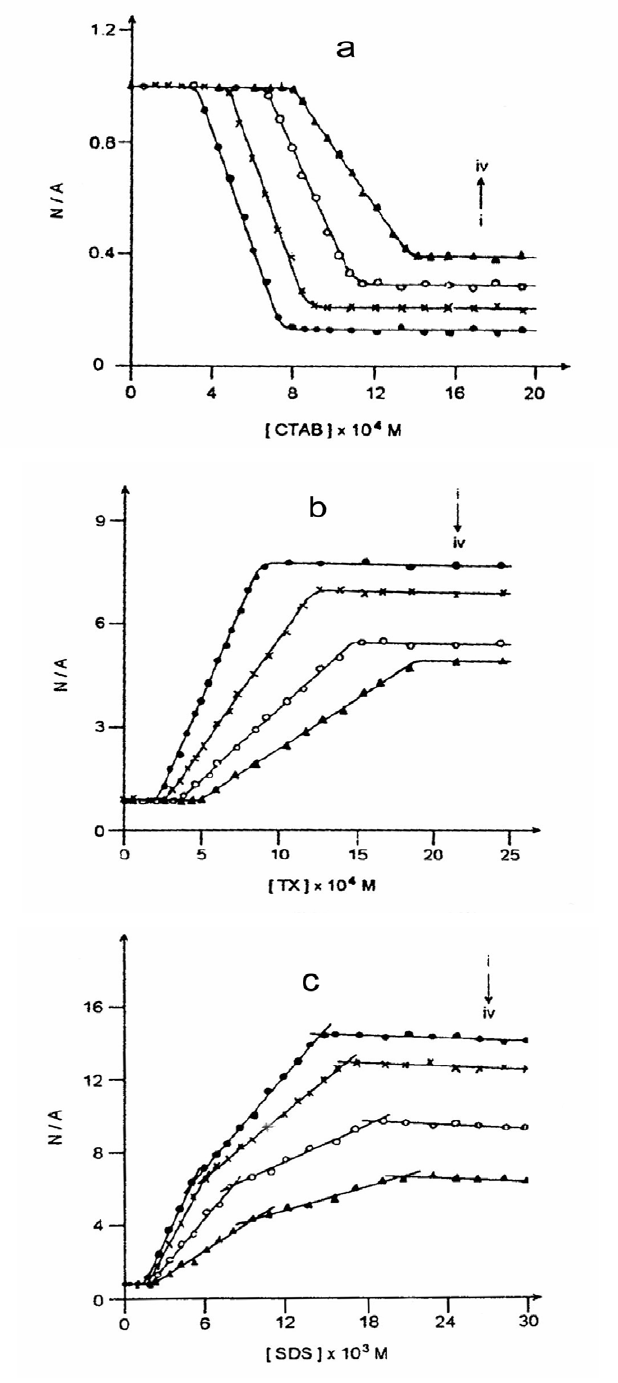
Figure 5. (a) Plot of neutral/anion emission yield ratio (N/A) against CTAB concentration in the presence of (i) 0.0, (ii) 1.0, (iii) 2.5 and (iv) 4.0 molar urea. (b) Plot of neutral/anion emission yield ratio (N/A) against TX concentration in the presence of (i) 0.0, (ii) 1.0, (iii) 2.5 and (iv) 4.0 molar urea. (c) Plot of neutral/anion emission yield ratio (N/A) against SDS concentration in the presence of (i) 0.0, (ii) 1.0, (iii) 2.5 and (iv) 4.0 molar